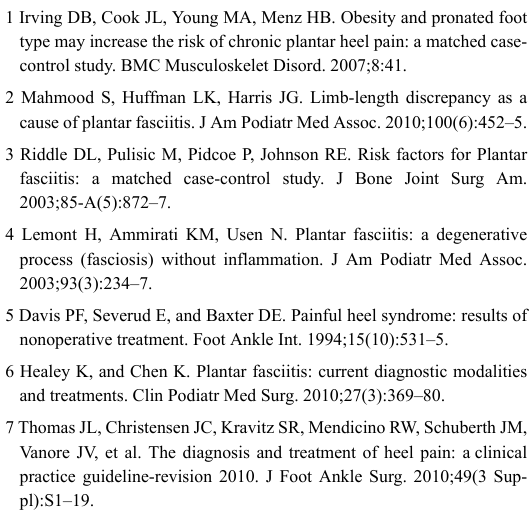
Group; no.No. of studies HESWT Placebo